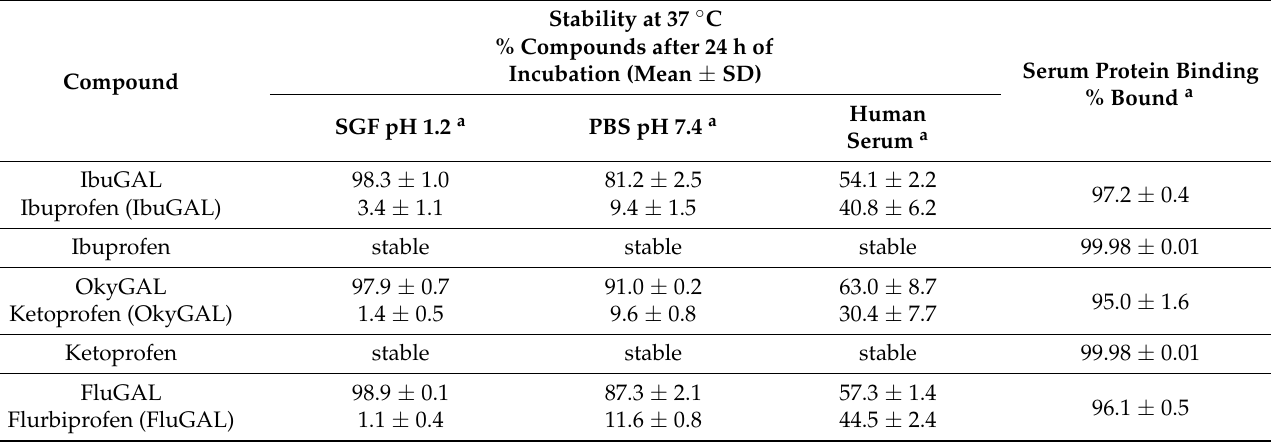
Table 2. The chemical stability in SGF (pH 1.2) and PBS (pH 7.4), enzymatic stability in human serum and serum protein binding (%bound) of galactosylated prodrugs compared to relative NSAIDs.